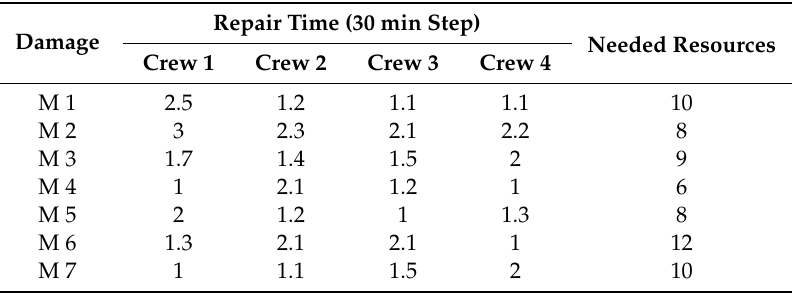
Table 2. Needed resources and time for damage.